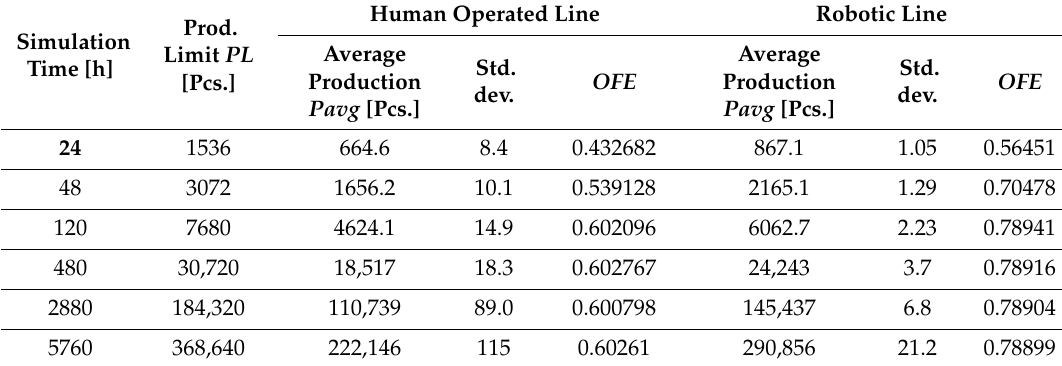
Table 2. Results of simulation experiments—average production value Pavg for 20 simulation runs with a confidence level at 90% (8-hour warm-up per week).